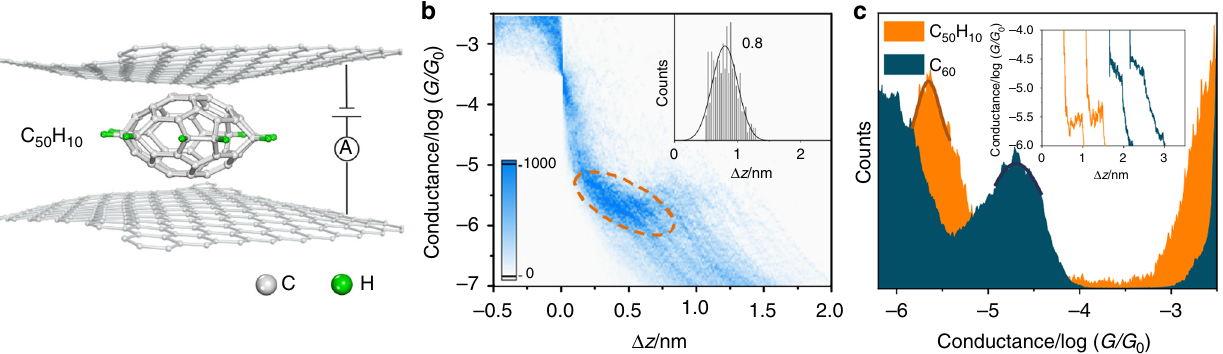
Fig. 2 Charge transport through graphene/single-C 50 H 10 /graphene junctions. a Schematic of graphene/single-C 50 H 10 /graphene junctions. b Corresponding two-dimensional conductance histogram obtained from ~1000 traces. The top right inset is the relative displacement distribution (The conductance range to determine the displacement are from 3.2 × 10 − 4 to 6.3 × 10 − 7 G 0 .). c Comparison of one-dimensional conductance histogram of the graphene/single-C 50 H 10 /graphene junctions. The top right inset is the individual conductance – displacement